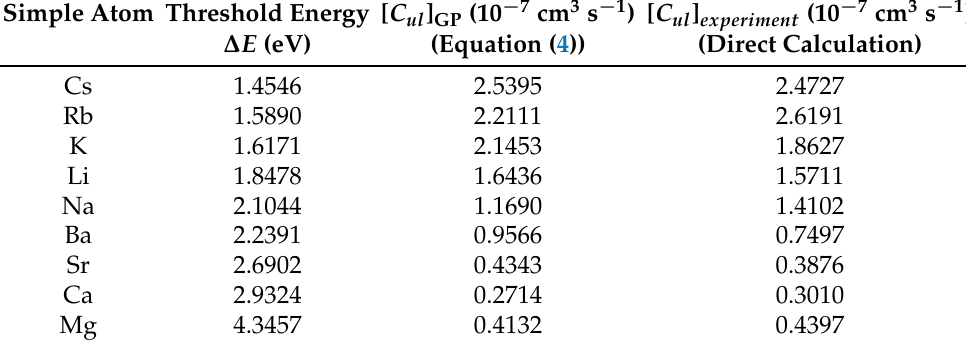
Table 2. s – p de-excitation rates of nine simple atoms obtained for T = 5000 K by using Equation (4) and by directly averaging experimental cross-sections via Equations (1) and